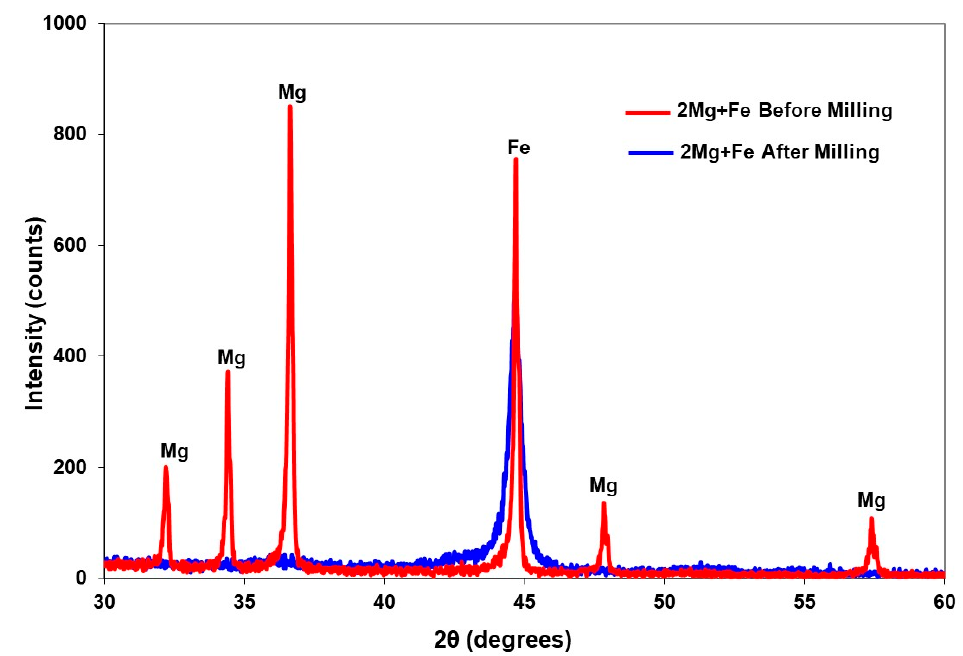
Figure 6. XRD patterns of the transition metal complex hydride before and after milling.